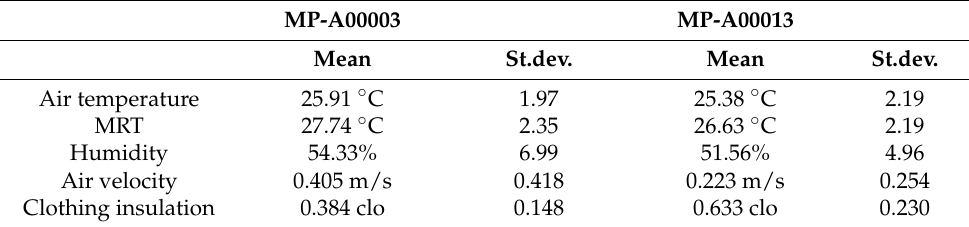
Table 3. Average parameters for the two considered platforms.